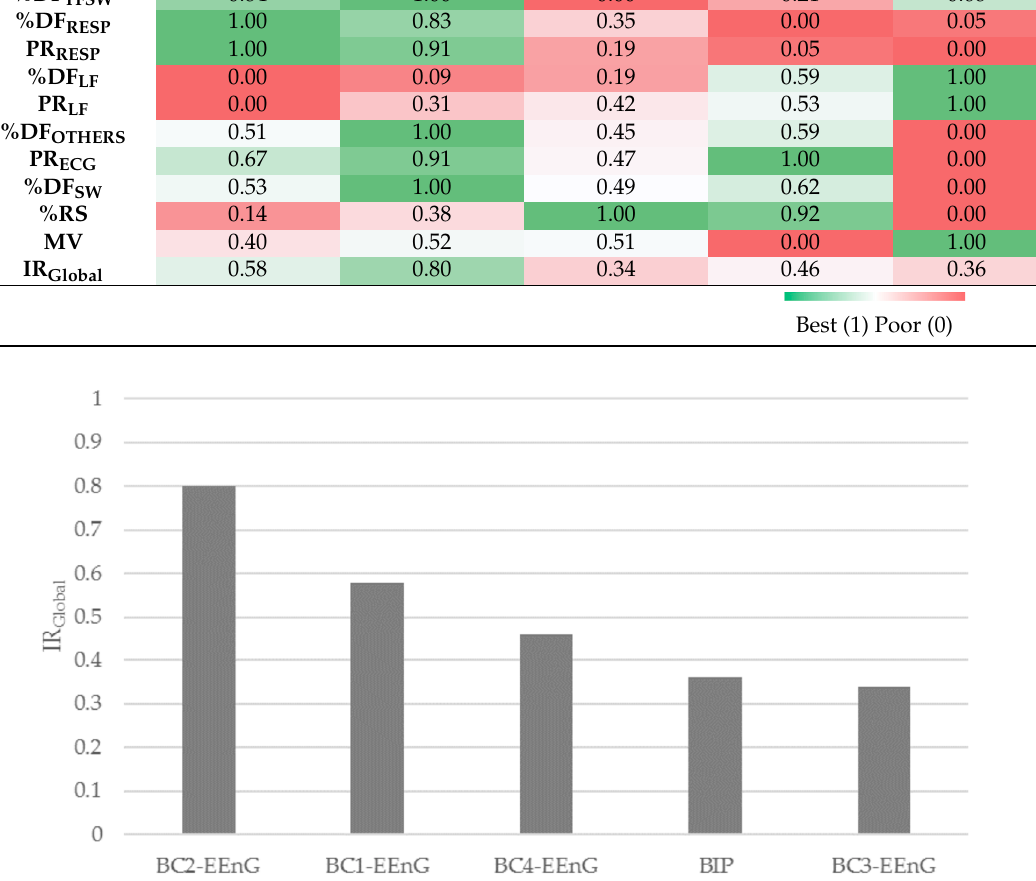
Figure 7. IR Global for each concentric bipolar configuration (BC1-EEnG, BC2-EEnG, BC3-EEnG and BC4-EEnG) and conventional bipolar (BIP).